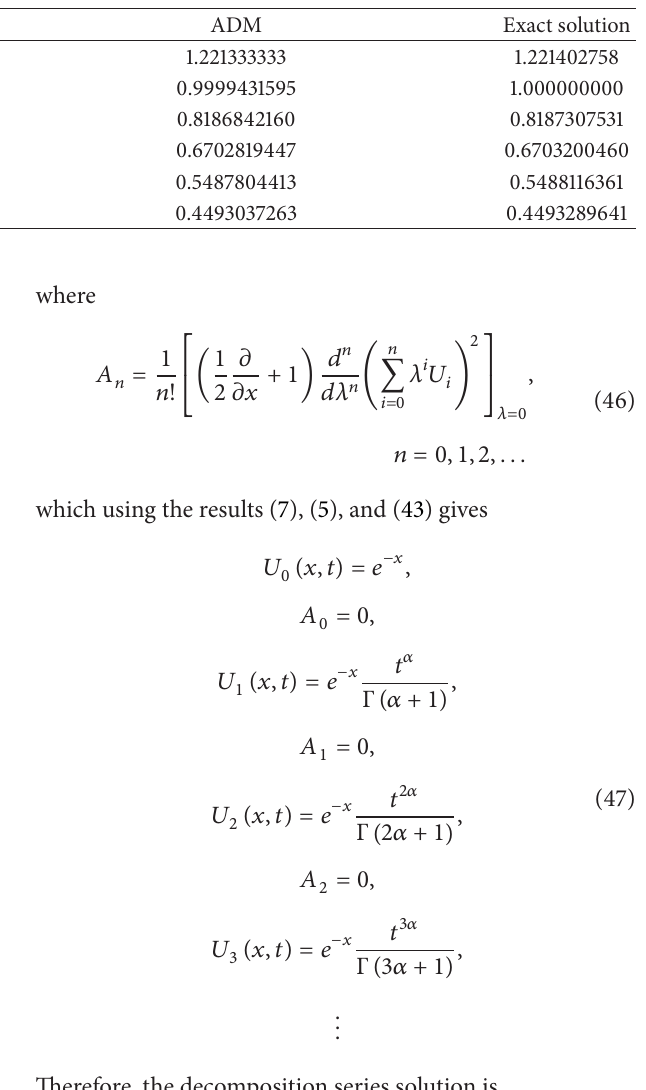
Table 1: Comparison study between HPSTM, ADM, and the exact solution when 𝛼 = 1.